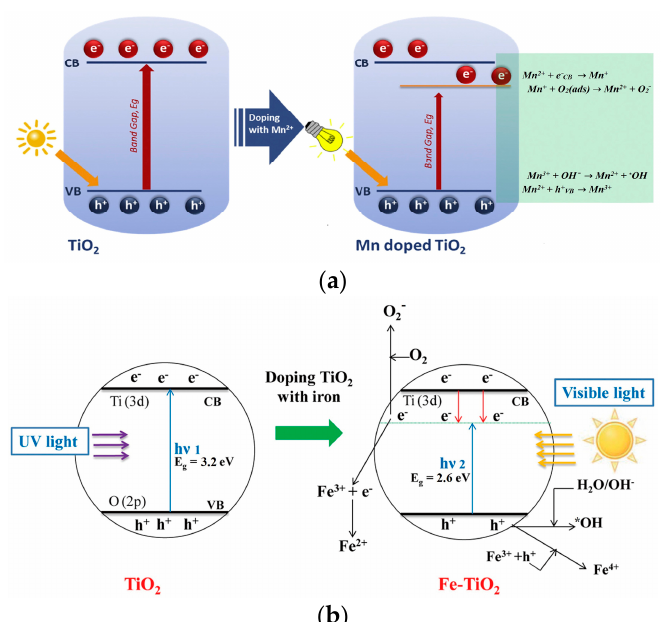
Figure 3. The charge transfer processes between excited electrons from the valence band of TiO 2 with ( a ) Mn 2+ ions of Mn-doped TiO 2 , and ( b ) Fe 3+ ions of Fe-doped TiO 2 . CB and VB are the conduction and valence bands of TiO 2 , respectively. Reproduced with permission from [92,95], respectively. Copyright Elsevier, 2017; Copyright American Chemical Society, 2013.